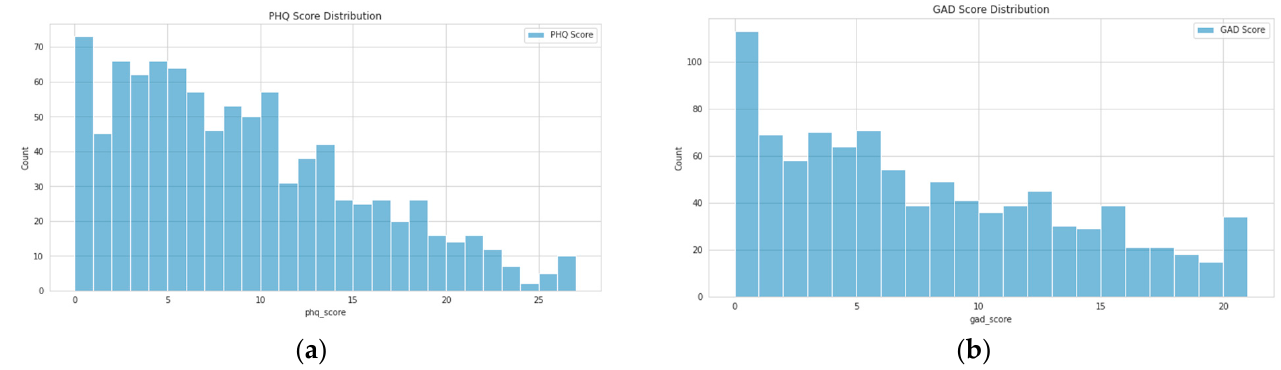
Figure 1. Distribution of scores for all participants included in the analysis: ( a ) PHQ-9 scores; ( b ) GAD-7 scores.